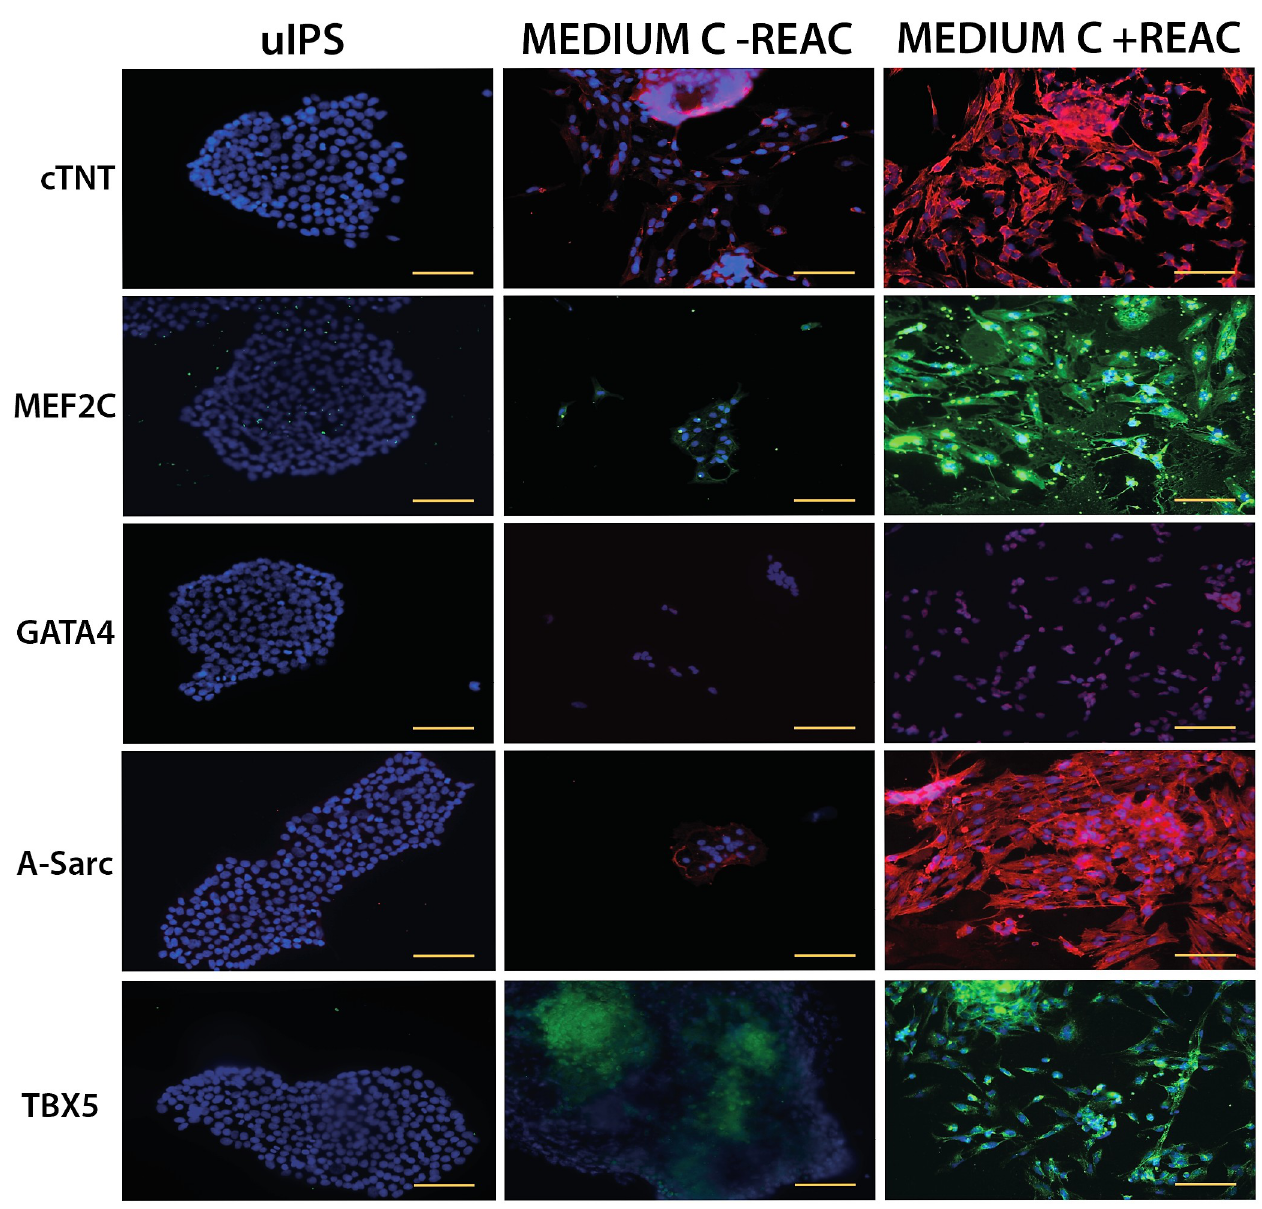
Fig 5. Immunohistochemical analysis of cardiac specific proteins. hUiPSCs exposed for 72 hours to conditioned medium in the absence (Medium C-REAC) or presence of REAC (Medium C+REAC) were disaggregated after 14 days from time 0 (undifferentiated hUiPSCs) seeded in chamber slide and processed for immunostaining using specific antibodies directed against: Troponin complex (cTnT), MADS box transcription enhancer factor 2 (MEF2C), GATA binding protein 4 (GATA4), α -sarcomeric actinin (A-Sarc) and T-Box protein 5 (TBX5). Confocal microscopy analysis was performed with Leica confocal microscope (LEICA TCSSP5). Nuclei were labeled with DAPI (blue). The yellow scale bars are 100 μ